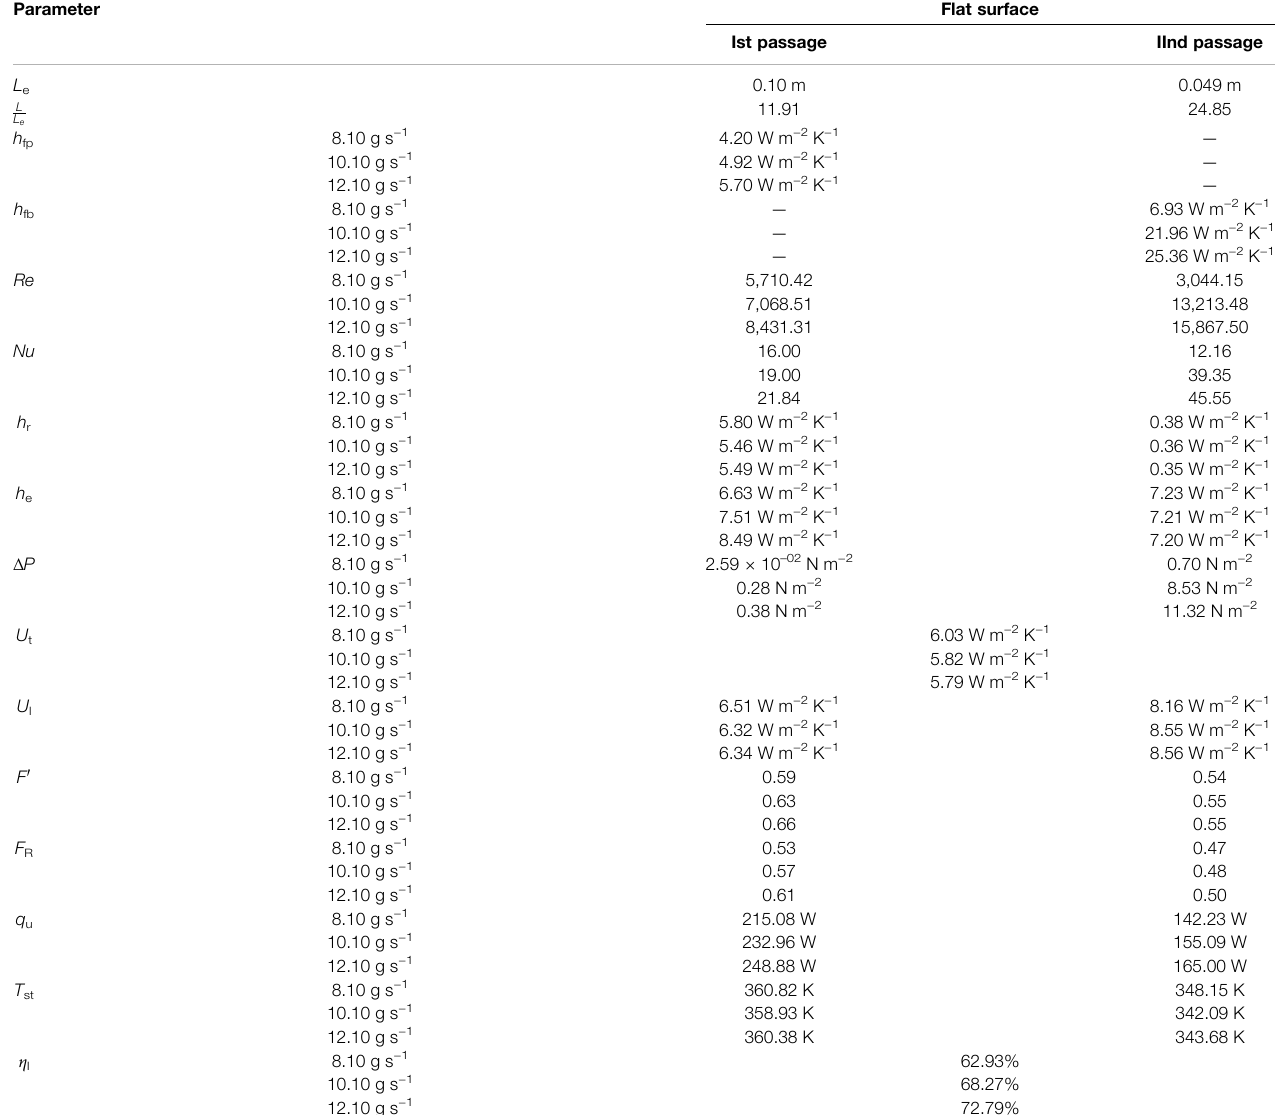
TABLE 5 | Parametric information of solar air collectors ( fl at plate collector with two-pass).